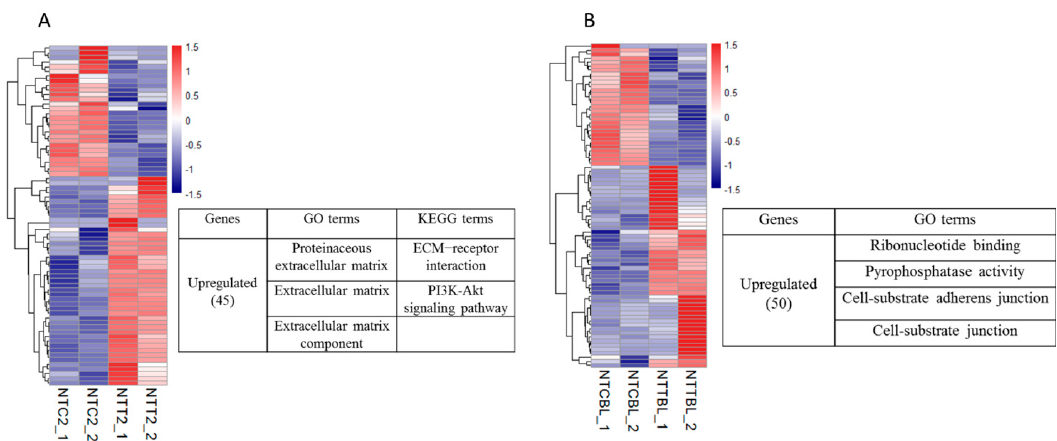
Figure 2. Effects of Vc treatment on the gene expression in cloned embryos. A heatmap illustration showing the genes affected by Vc treatment in the cloned embryos. Differentially expressed genes (DEGs) were analyzed under the conditions of p < 0.01, fold change (FC) > 2, and fragments per kilobase of exon per million reads mapped (FPKM) > 1 in at least one group. Genes that were upregulated by Vc treatment were enriched by gene ontology (GO) and KEGG analysis. ( A ) Gene expression changes in the two-cell stage. ( B ) Gene expression changes in the blastocyst stage. NTC2/NTCBL, cloned two-cell embryos or blastocysts produced by the control donor cells; NTT2/NTTBL, cloned two-cell embryos or blastocysts produced by the Vc-treated donor cells.